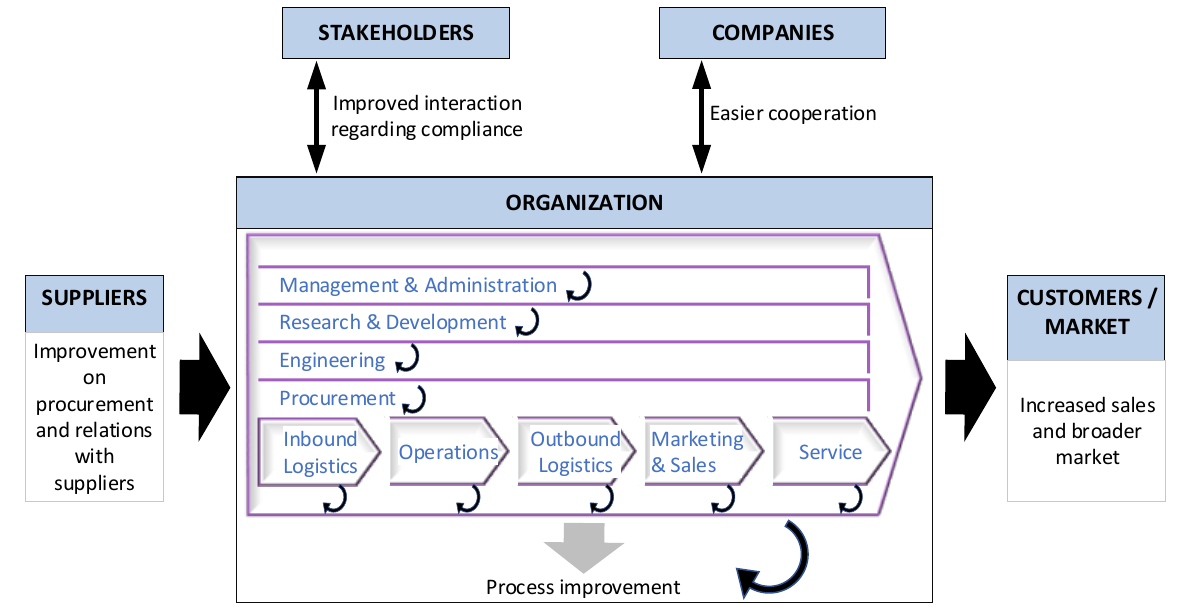
Figure 3. The ISO Methodology at a glance.